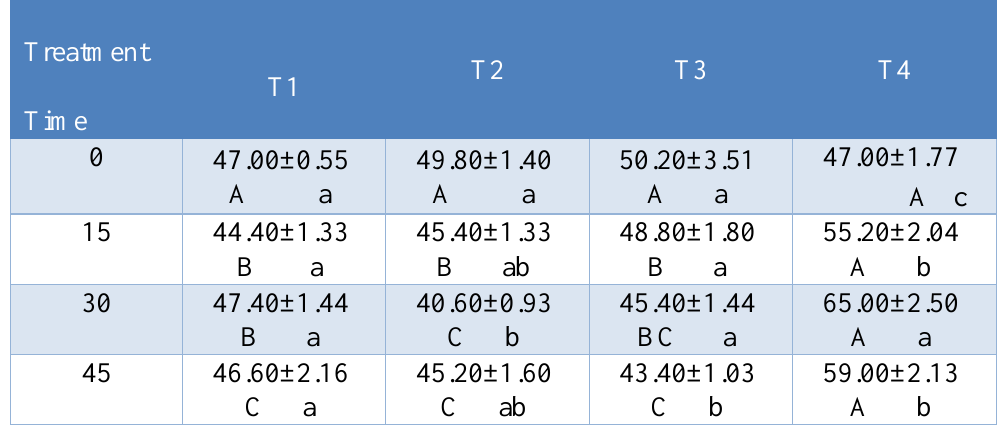
Table, 5: Effects of Salvia Officinal's (SO) and Salvia Officinal's Silver Nanoparticles (SOSNP) on serum urea concentration (mg/dl) in normal and methotrexate (MTX) treated rats. Treatment